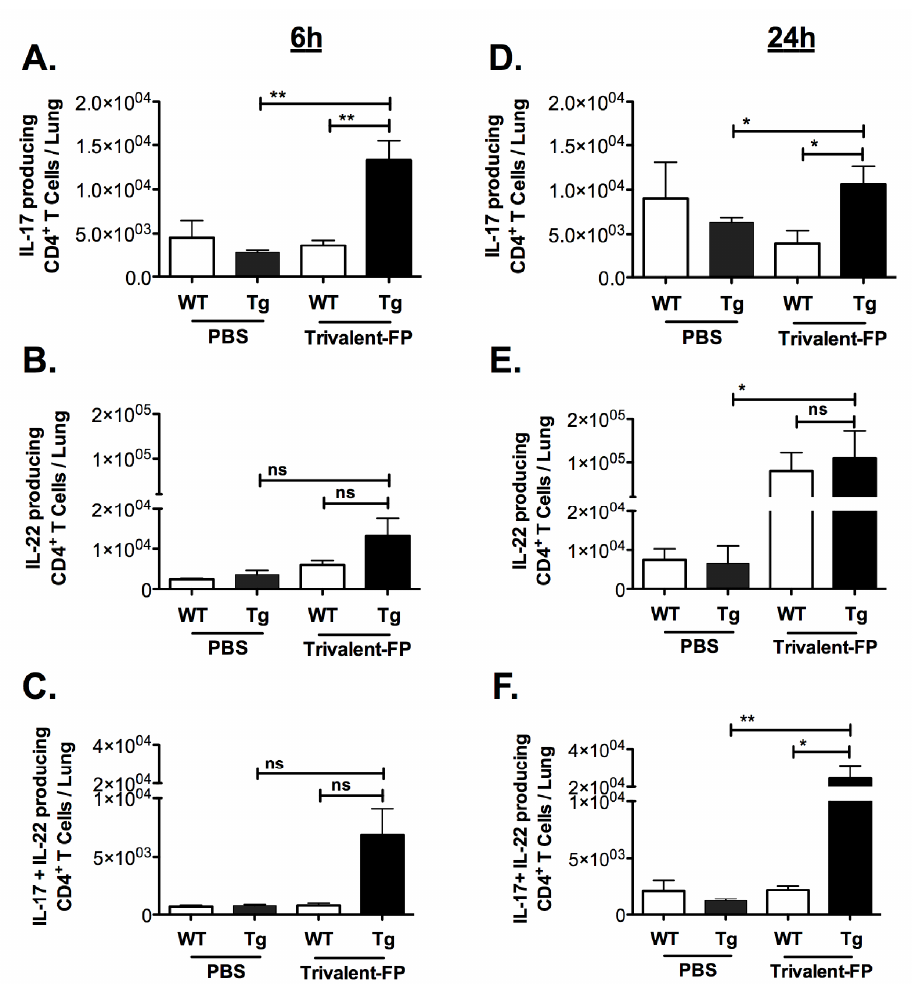
Figure 4. Intranasal immunization with hFc γ RI-targeted PspA induced pulmonary antibody and cell-mediated immunity: groups of WT (wild type) and Tg (transgenic) mice were immunized with PBS or Trivalent-FP (208 pmol) via the intranasal route and infected with S. pneumoniae 6 weeks post-booster immunization. At 6 h ( A – C ) and 24 h ( D – F ) post-infection, mice were euthanized and their lungs were excised. Single cells were isolated from lungs and stained with CD45-antigen-presenting cell (APC)-Fire-750, CD3-V450, CD4-FITC, IL-17-PE, and IL-22-APC. By flow cytometry analysis, single cells were discriminated and further gated on the CD3 + CD4 + population, and the CD3 + CD4 + T cells producing IL-17 alone ( A , B ), IL-22 alone ( C , D ), or both IL-17 and IL-22 ( E , F ) were enumerated. Mean ± SE of data from two independent experiments is shown ( n = 6 / group, * p = 0.05, ** p = 0.01, ns = not significant). Statistical significance between indicated groups was evaluated by Mann–Whitney nonparametric test.